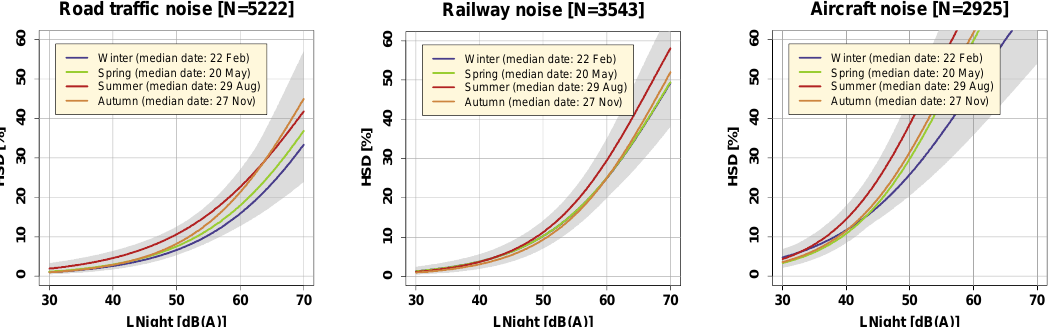
Figure 10. Exposure-response relationships obtained by respondents having declared that they used prescription sleep medication (“yes”) in the four weeks prior to the survey, and by respondents not having taken sleep medication (“no”). Curves are based on the adjusted model in the full sample with covariates centered on the mean and show (partly overlapping) 95% confidence intervals as shaded areas.